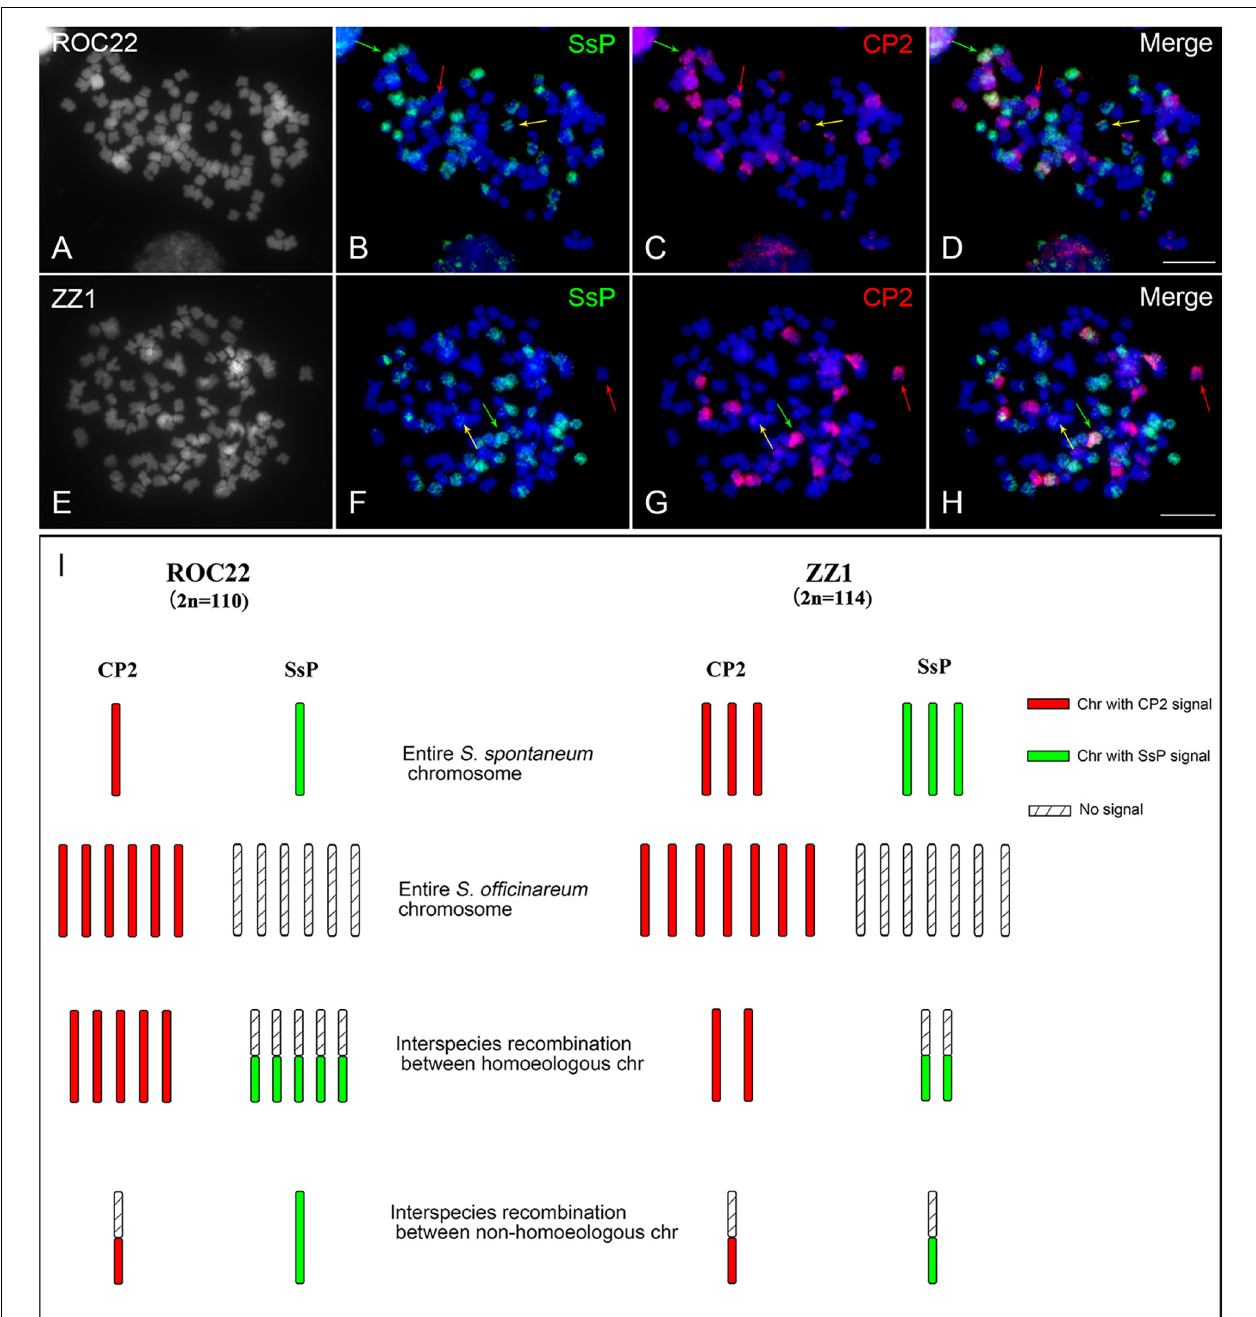
FIGURE 6 | FISH assay using probes of CP2 and S. spontaneum -specific repeats in the sugarcane modern cultivars ROC22 and ZZ1. Dual-color FISH assay using CP2 (red) and the S. spontaneum -specific probe SsP (green) in sugarcane cultivars ROC22 (A–C) and ZZ1 (D–F) . (A,D) Somatic metaphase chromosomes stained with 4 (cid:48) ,6-diamidino-2-phenylindole (DAPI) shown in gray. A representative of entire S. spontaneum and entire S. officinarum chromosomes are indicated by green and red arrows, respectively. Yellow arrows indicate the translocation chromosome in (B–D) and the interspecific recombination chromosome between non-homologous chromosome in (F–H) , respectively. Scale bars, 10 µ m. (I) Diagram illustrating chromosome 2- and chromosome 2-derived chromosomes in cultivars. Each bar represents a chromosome, with colors corresponding to the CP2 or SsP probes used in Figure 6 . The chromosomes with CP2 signals are shown on the left of each cultivar. The detection of the SsP signal is shown on the right from the corresponding chromosome with the CP2 signal. Chromosomes with overlapping whole-chromosome signals of CP2 and SsP represent the entire S. spontaneum chromosome. Chromosomes with only whole-chromosome CP2 signals represent the entire S. officinarum chromosome. Chromosomes with whole-chromosome CP2 signals and regional SsP signals represent interspecific recombination between homoeologous chromosomes. Chromosomes with whole-chromosome SsP signals and regional CP2 signals represent interspecific recombination between non-homoeologous